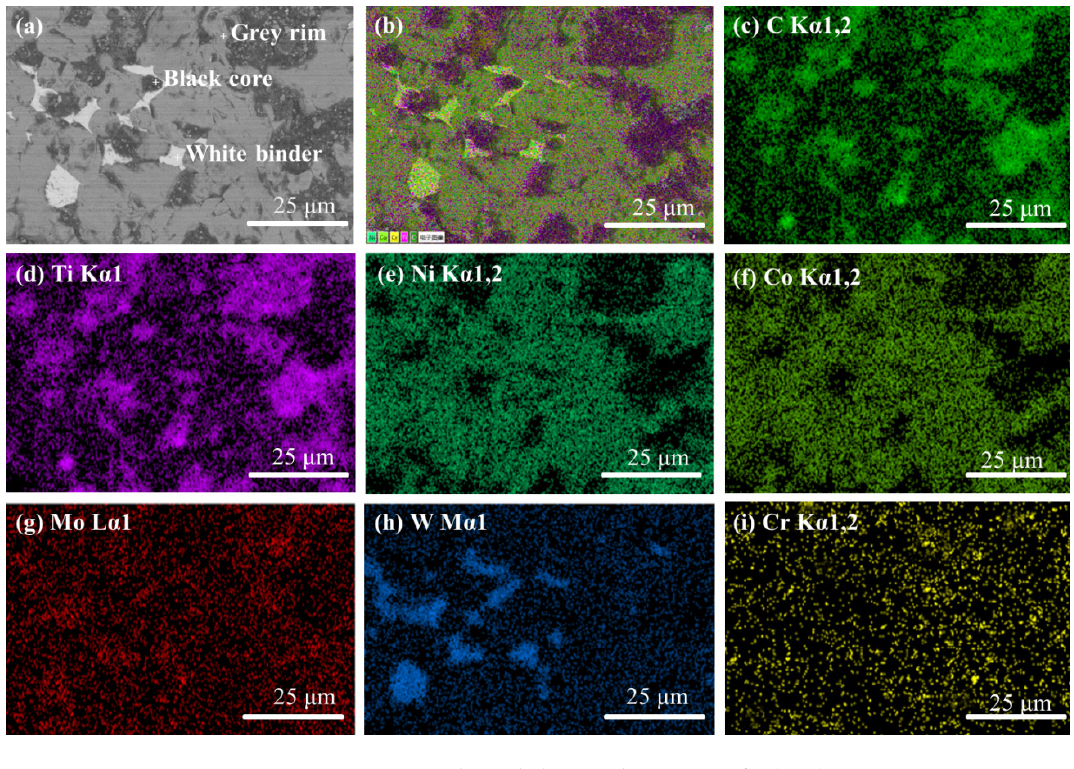
Figure 7. SEM–BSE micrographs and elemental mapping of Ti(C,N) ceramics.